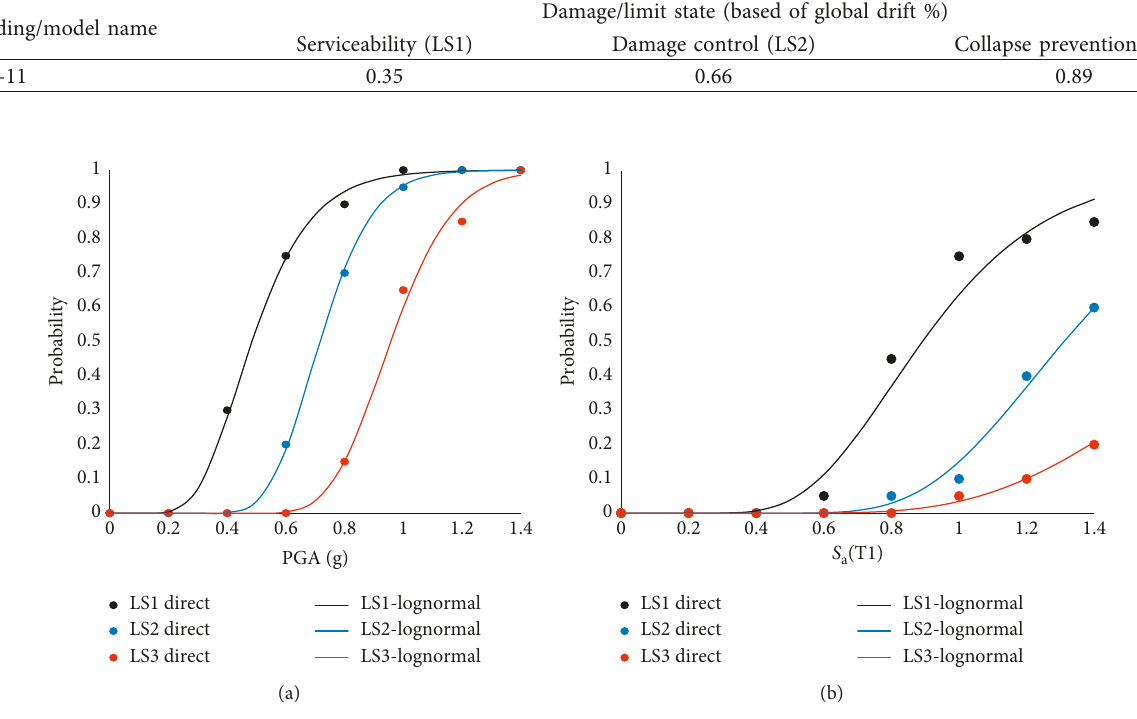
Figure 8: Derived fragility relationships for all IMs: (a) seismic fragility for PGA; (b) seismic fragility for S a Table 6: Lognormal distribution parameters for fragilities against PGA and S a (T1) for the considered school building typology.